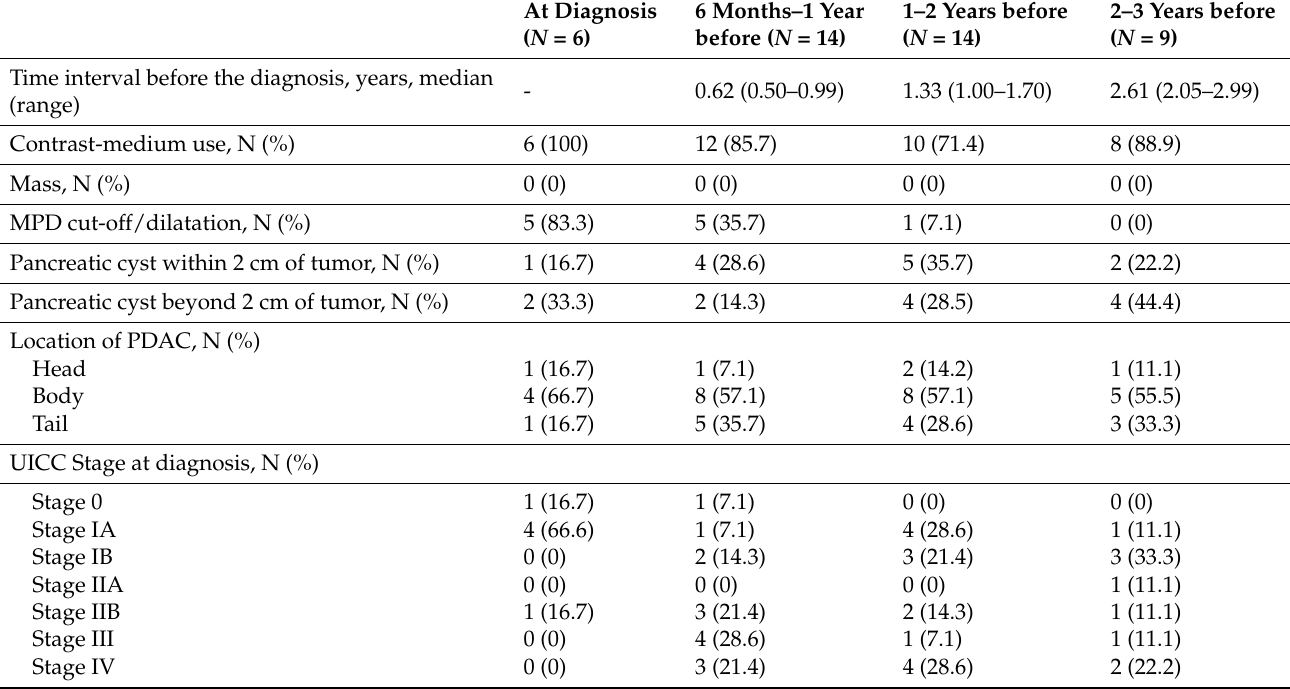
Table 3. Characteristics of the patients presenting focal parenchymal atrophy.